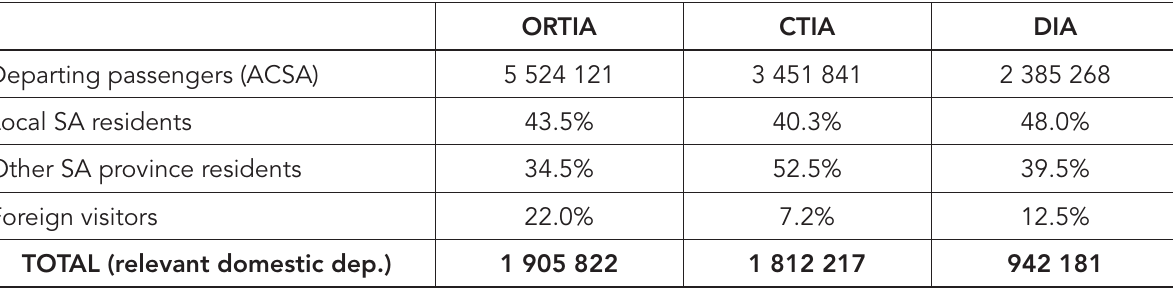
Table I: Domestic passenger split